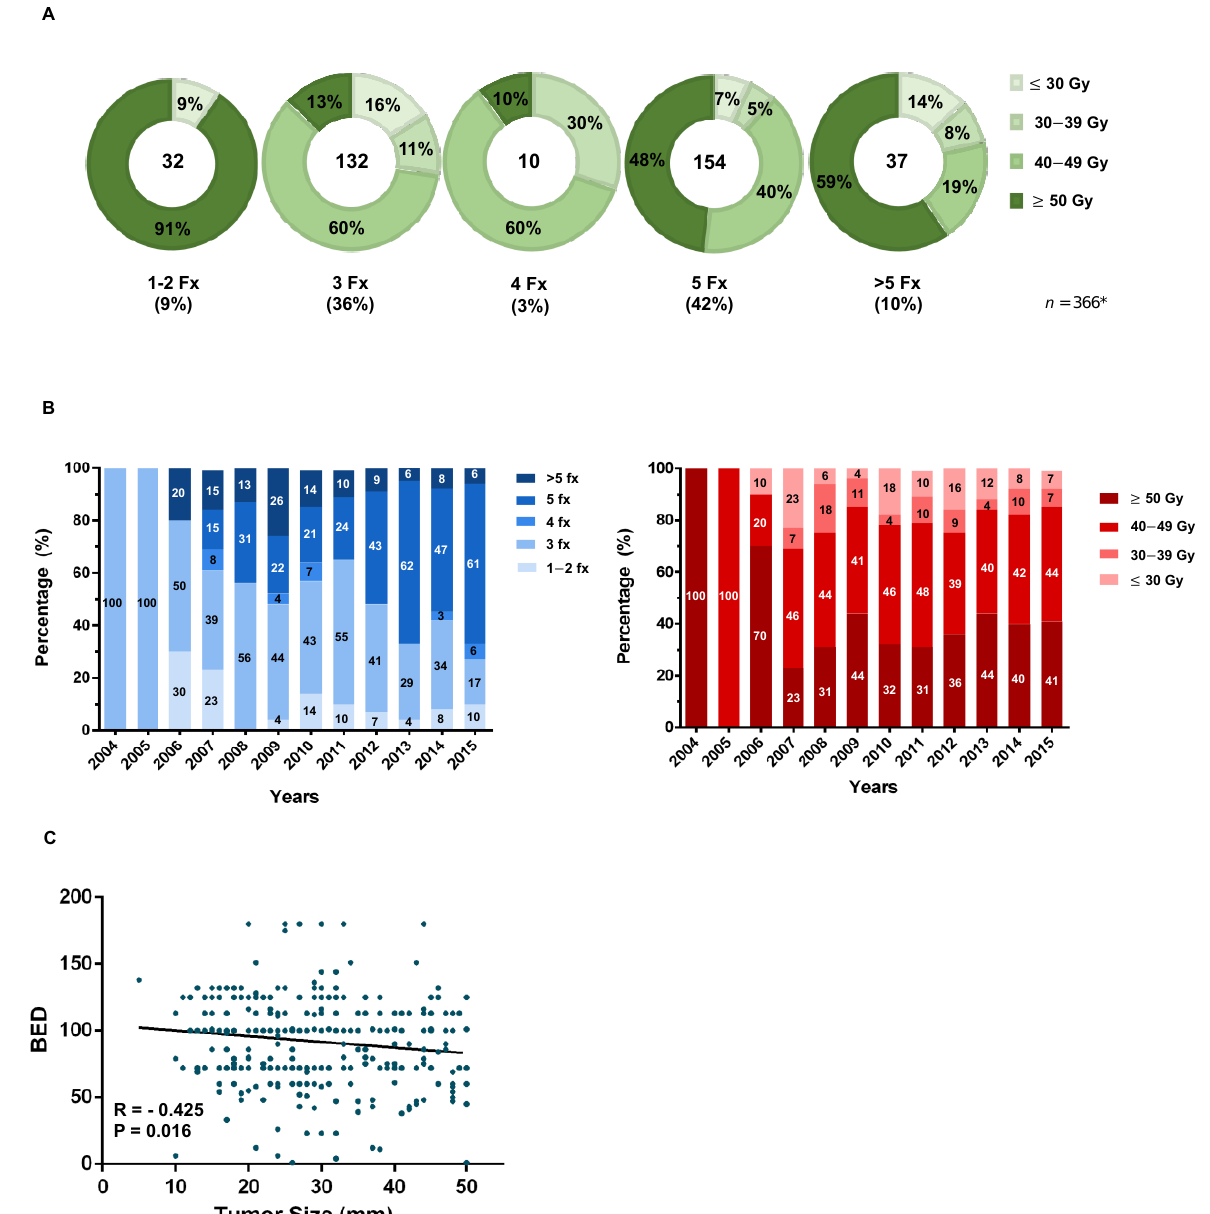
Figure 2. Characterization of SBRT treatment. Distribution of dose and fractionation regimens with total numbers and proportions are displayed for the study population with SBRT (n = 366) ( A ). Fx, fractionation regimen; * one patient with 50 Gy treatment had no data of the fractionation regimen. The use of dose and fractionation regimens over the study period is displayed ( B ). The relationship between BED and tumor size ( C ) is demonstrated in a scatter plot (Pearson’s correlation analysis).